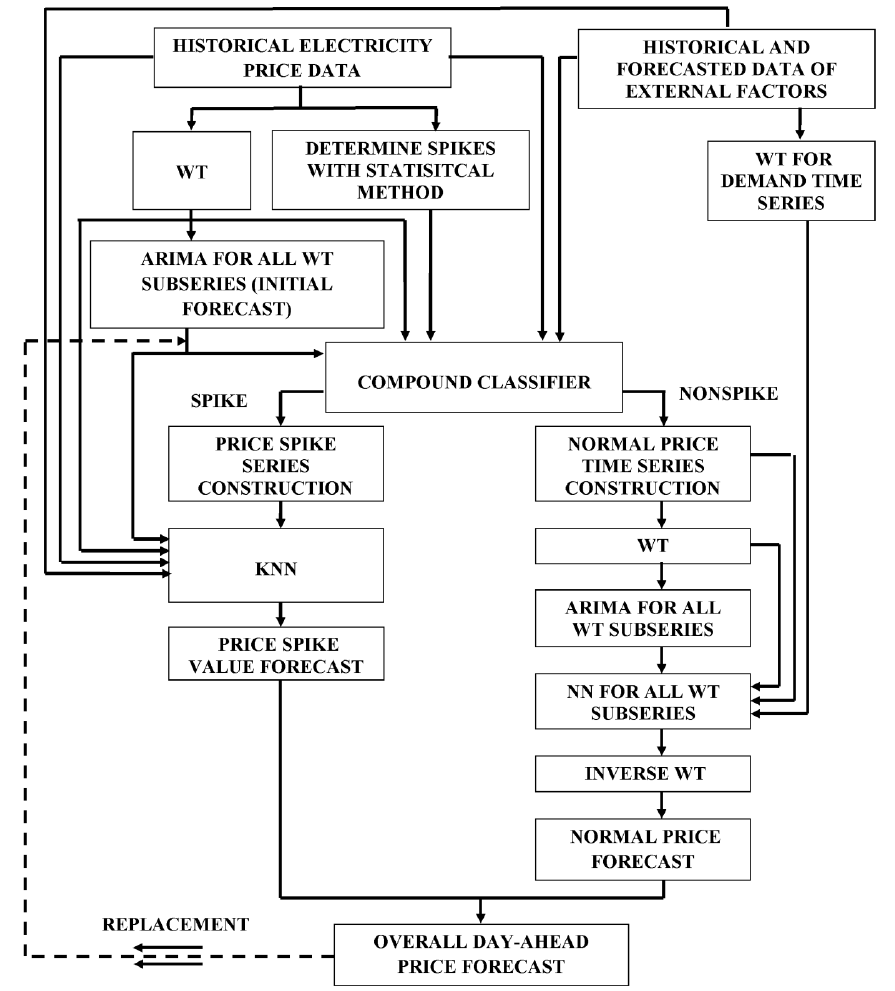
Figure 4. Procedure of the proposed